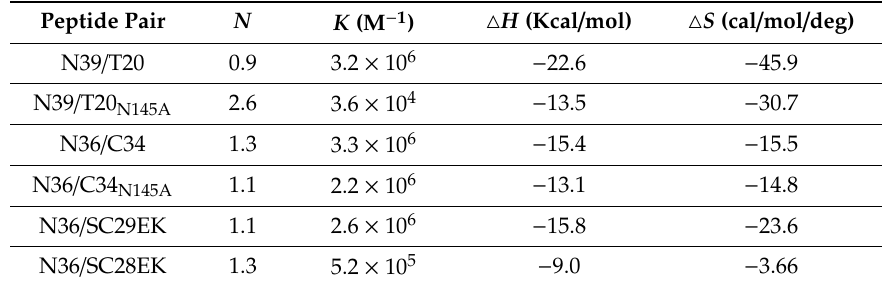
Figure 4. E ff ects of the N145A mutation on the secondary structure and thermostability of 6-HB. The α -helicity ( A ) and thermostability ( B ) of the native and mutant C34 in complexes with N36 and the α -helicity ( C ) and thermostability ( D ) of the native and mutant T20 in complexes with N39 were respectively determined by circular dichroism (CD) spectroscopy. The final concentration of each peptide was 10 µ M in PBS. The experiments were repeated two times, and representative data are shown. Table 1. Thermodynamic parameters of the interactions between the N- and C- terminal heptad repeats (NHR- and CHR-derived) peptides determined by isothermal titration calorimetry